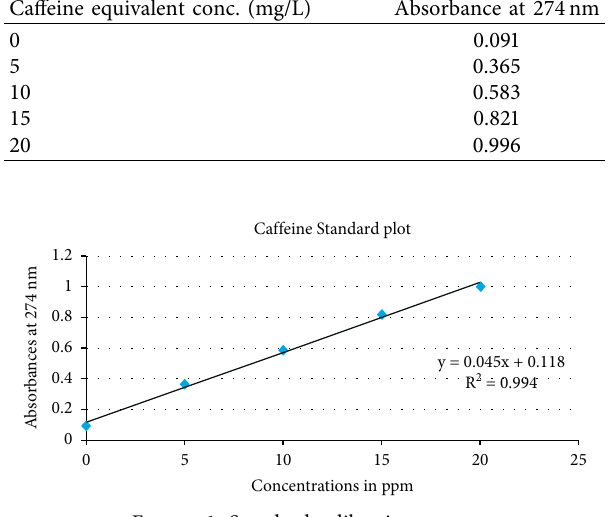
Figure 1: Standard calibration curve.